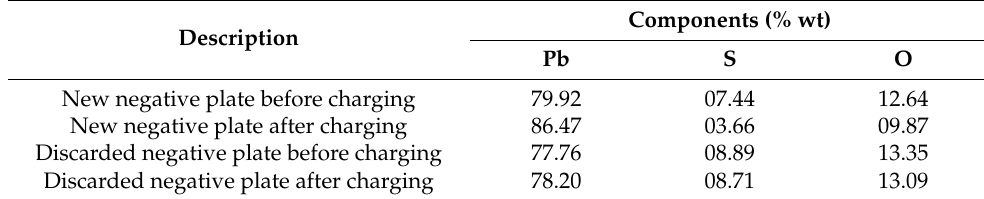
Table 3. EDX analysis of new and discarded negative plates before and after